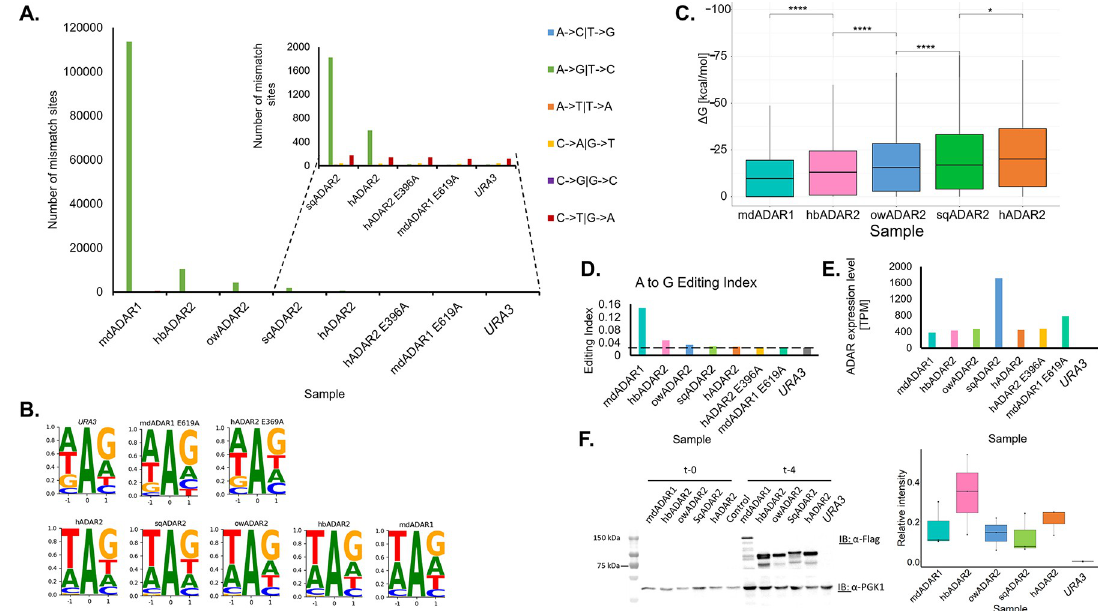
Fig 3. Editing activity in ADAR-expressing yeast strains is strongest for mallard duck ADAR1. (A) Res-scanner detection of editing sites (Methods) for five yeast strains expressing different active ADAR enzymes results in varying amounts of sites, spanning two to three orders of magnitude. Note that due to the large numbers for mdADAR1 (113,672 sites, in a 12Mbp genome) and hbADAR2 (10,443), the results for the other strains are invisible in the main graph, and thus these results are plotted again in the inset. The (three rightmost) control strains show no excess of A-to-G mismatches, attesting for no editing activity as expected. (B) Distribution of the neighboring nucleotides to the predicted editing sites reveals the familiar editing motif (mostly a depletion of G upstream) for all strains expressing active ADARs, but not for the control ones. (C) Thermodynamic stability of the predicted secondary structures surrounding the detected sites (Methods). Lower (more negative) Δ G indicates a more stable structure. Note that no structure was found for 113, 379, 939, 2526 and 32197 sites, for the five organisms, respectively. Their Δ G was set to zero. (D) Genome-wide editing index (Methods) for the five active ADAR strains and three control ones. The dashed line represents the base-line noise level. (E-F) ADAR expression levels (TPM) (E) and protein levels (F) for the different strains do not account for the wide differences in the number of sites detected. Logarithmically growing cells carrying the indicated plasmids were grown in SC-URA+Raf (ADAR expression is off). 2% Gal was then added for 4 hours, to induce the ADAR genes expression. Cell lysates from the SC-URA+Raf and SC-URA+Gal (t-0 and t-4 respectively) were separated by SDS-PAGE and immunoblotted with anti-FLAG ( α -FLAG. Anti-3-phosphoglycerate kinase 1 ( α -PGK1) was used as a loading control. Relative intensity was measured as pixel density for each sample with consideration of the loading control. Protein levels were quantitated relative to the loading control in three independent experiments. Whiskers represent the minimum and maximum values measured from three independent experiments. Stars above the boxplots indicate a statistically significant difference between the means of two samples (ns: p > 0.05; � : p < = 0.05; �� : p < = 0.01; ��� : p < = 0.001; ���� : p < = 0.0001).